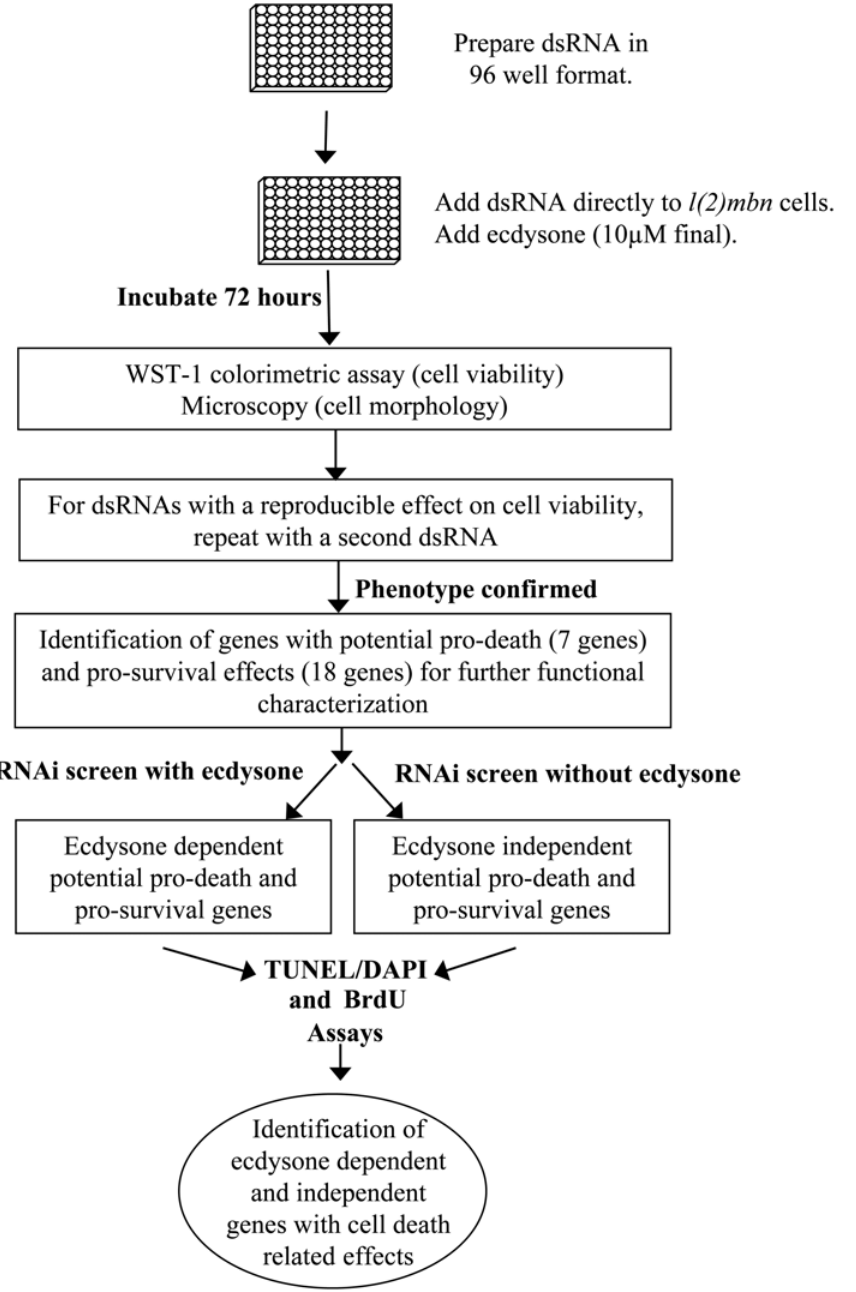
Figure 2. Overview of RNAi screen in l(2)mbn cells. A set of 460 genes which included known transcription factors, cell death and autophagy genes, as well as genes associated transcriptionally with ecdysone-induced cell death of the Drosophila salivary gland were chosen for this functional study. In our initial screen, cells were treated with ecdysone and dsRNA corresponding to each of these genes. A viability assay (WST-1) was used to identify genes with potential pro-death or pro-survival functions, and microscopy was used to visualize cell morphology. For the reproducible positive hits, a second dsRNA was used to confirm the viability phenotype. The screen identified 7 potential pro-death and 18 pro-survival genes. The RNAi/WST-1 screen was repeated with and without ecdysone to determine ecdysone dependency for the 25 identified genes. TUNEL/DAPI and BrdU assays were performed to identify genes with cell death and/or cell proliferation related effects.